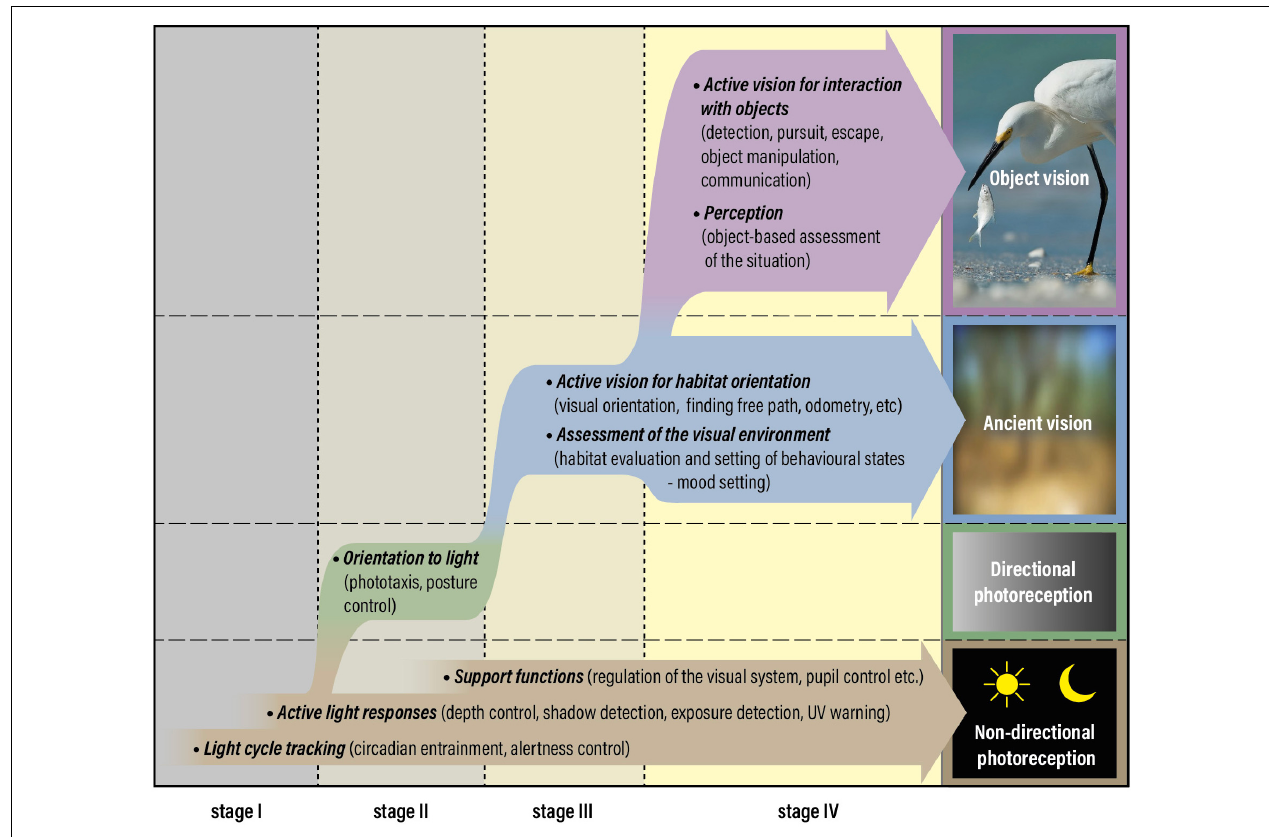
FIGURE 1 | Photoreception and vision have evolved through four distinct stages, starting with non-directional photoreception at stage I, acquisition of directional photoreception at stage II, which is replaced by ancient vision at stage III and complemented by object vision at stage IV. True vision and eyes are associated with the introduction of stage III. The figure was originally prepared for a recent review (Nilsson, 2021) but has been adapted to the new concepts of ancient vision and object vision argued for in this manuscript. Ancient vision was not reduced after the introduction of object vision but could massively boost its performance without much additional cost. Consequently, between stages III and IV, vision changed from a minor to a major sensory